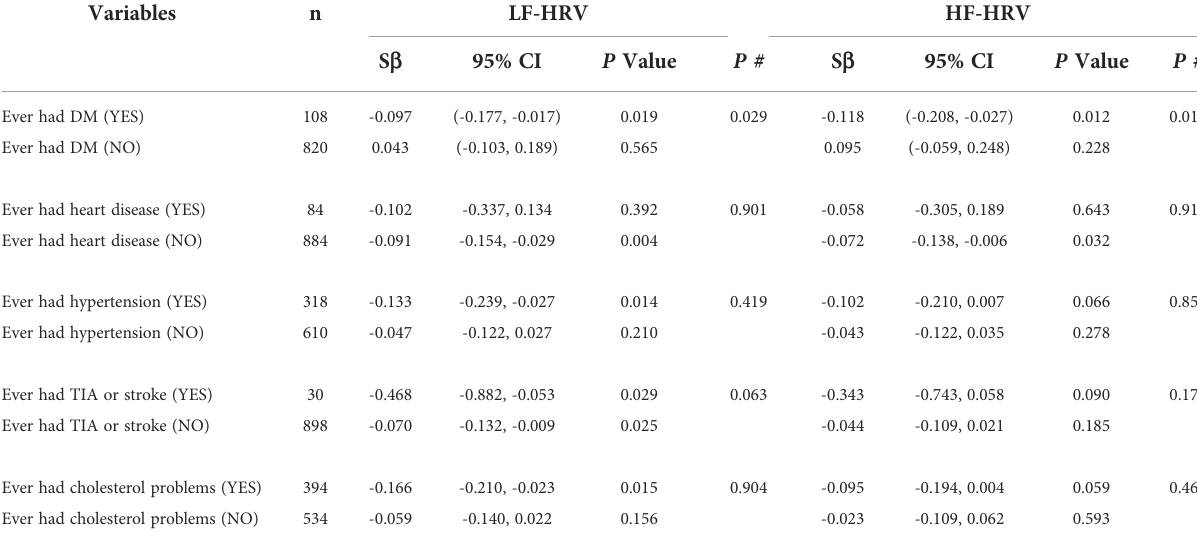
TABLE 3 Subgroup analyses for association between blood hemoglobinA1c and HRV by adding “ CVD history ” as strati fi cation variables.